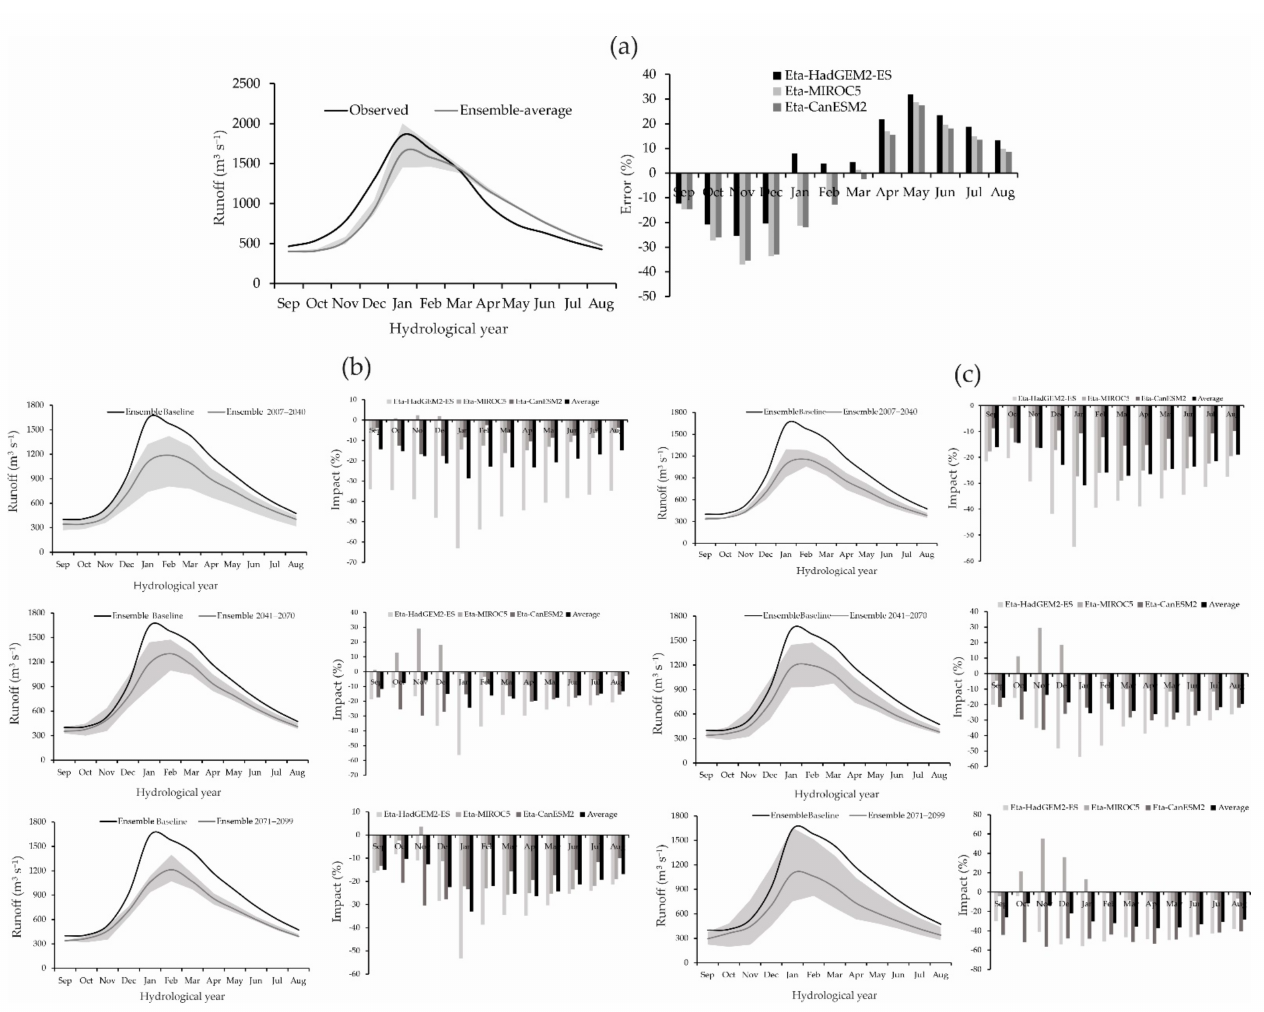
Figure 8. Average observed and simulated (ensemble) monthly hydrograph and respective errors (%) in the baseline ( a ) and projections (impacts, in %) of the RCMs on runoff throughout XXI Century in the GRB-Furnas: ( b ) RCP4.5 and ( c )